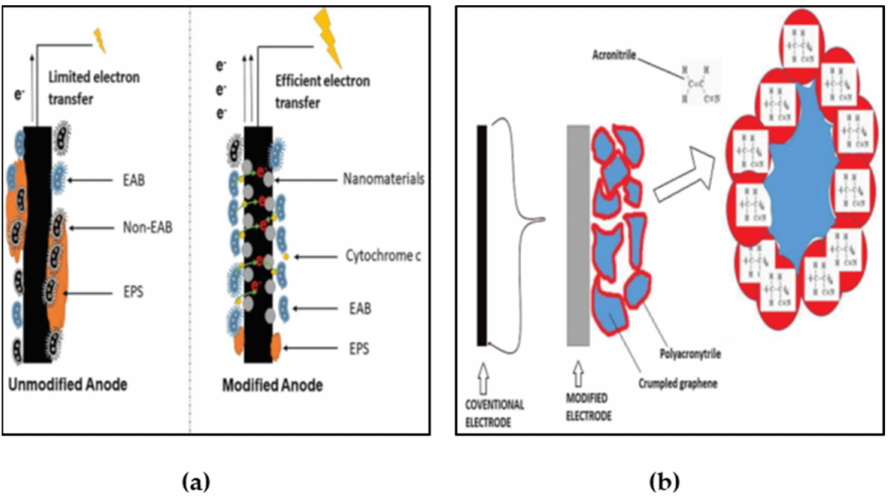
Figure 9. ( a ) General picture of nanomaterial modified anode and ( b ) graphene modified anode. Reproduced from [147] under creative commons attribution